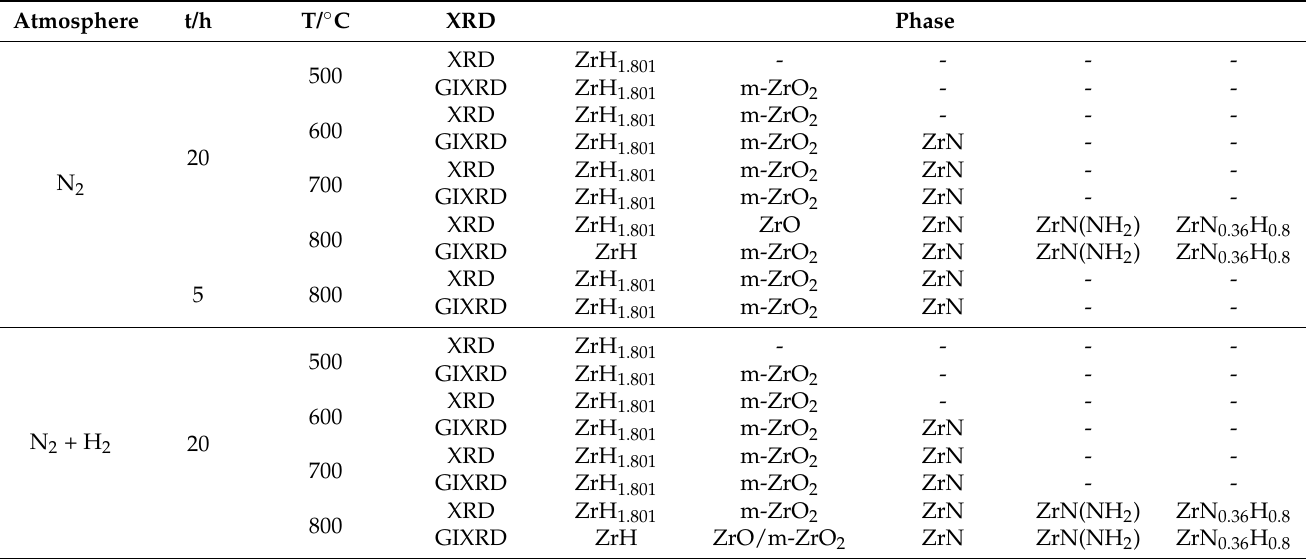
Table 4. The phase of zirconium hydride with nitride film prepared in different conditions.